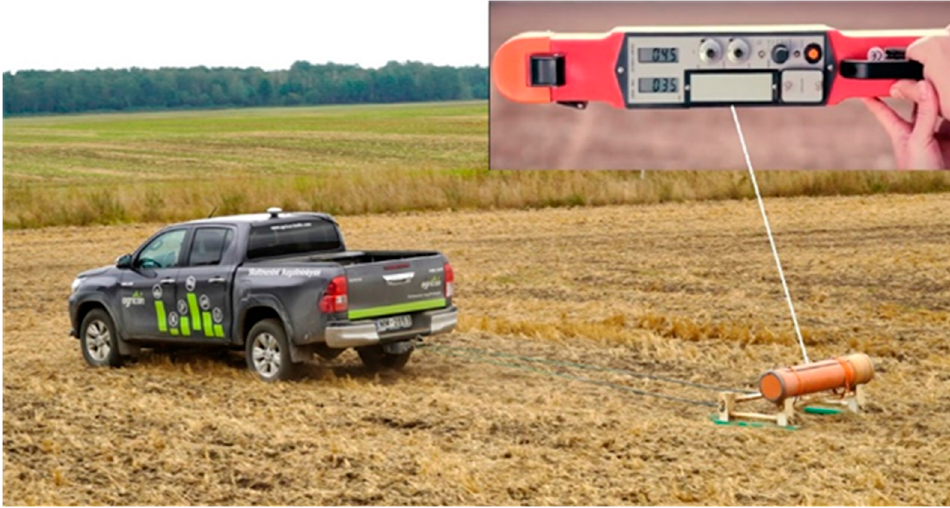
Figure 9. EM38-MK2 remote sensing device constructed on a plastic sledge [22].